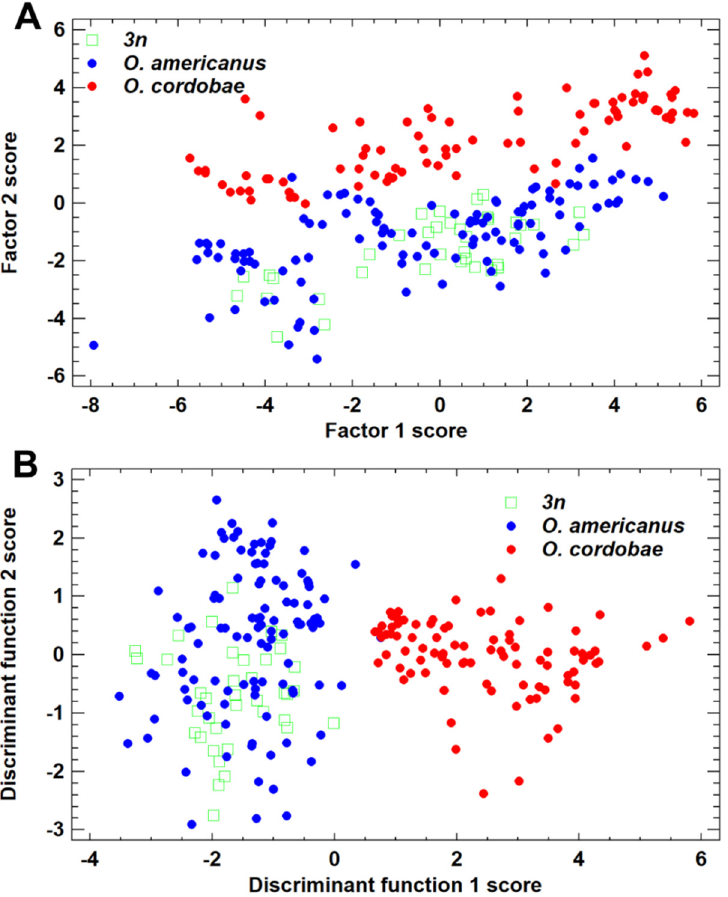
Figure 4. Bioacoustic differentiation of di-, tri-, and tetraploid Odontophrynus taxa. ( A ) Scatter plot of factor scores without a priori delimitation of groups. ( B ) Scatter plot of discriminant function scores with a priori delimitation of groups. Each symbol represents one individual.